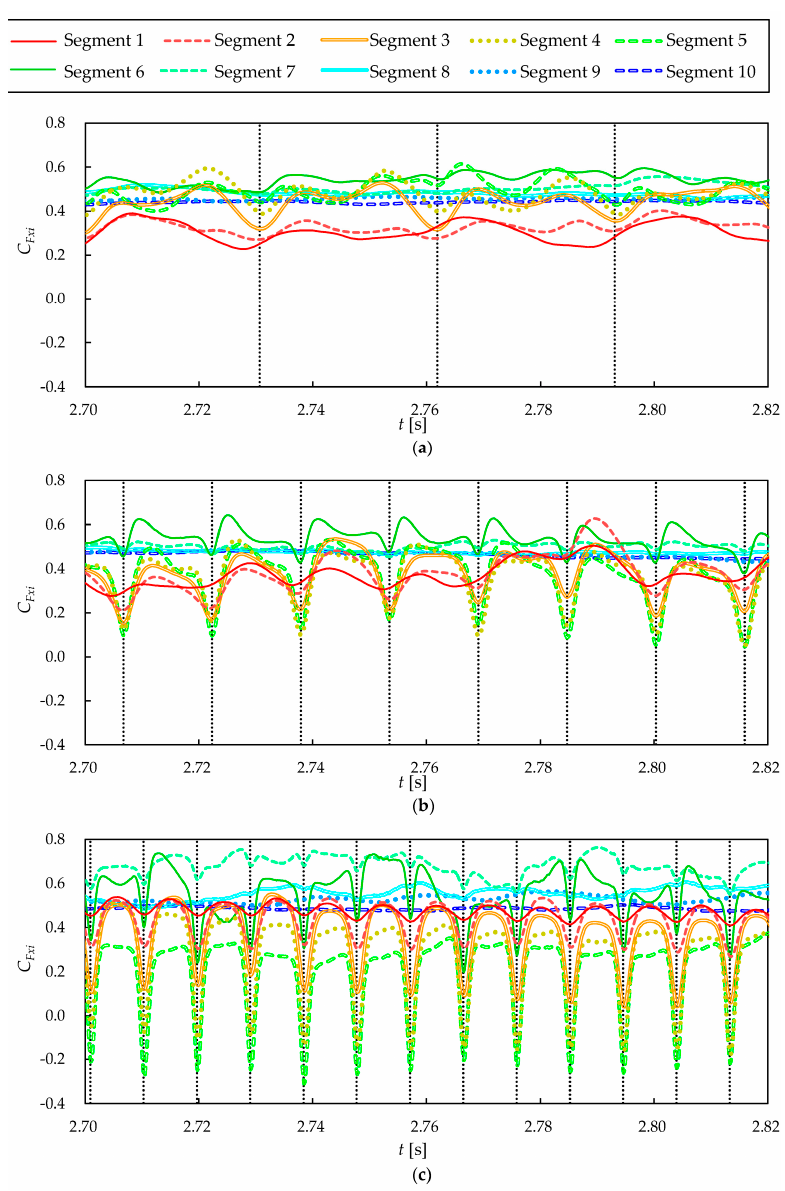
Figure 15. Time history of the instantaneous drag coefficient of each tower segment. The vertical dotted lines indicate the time at which the blade nearest the tower is at Ψ = 0°. ( a ) λ = 3; ( b ) λ = 6; and ( c ) λ = 10.